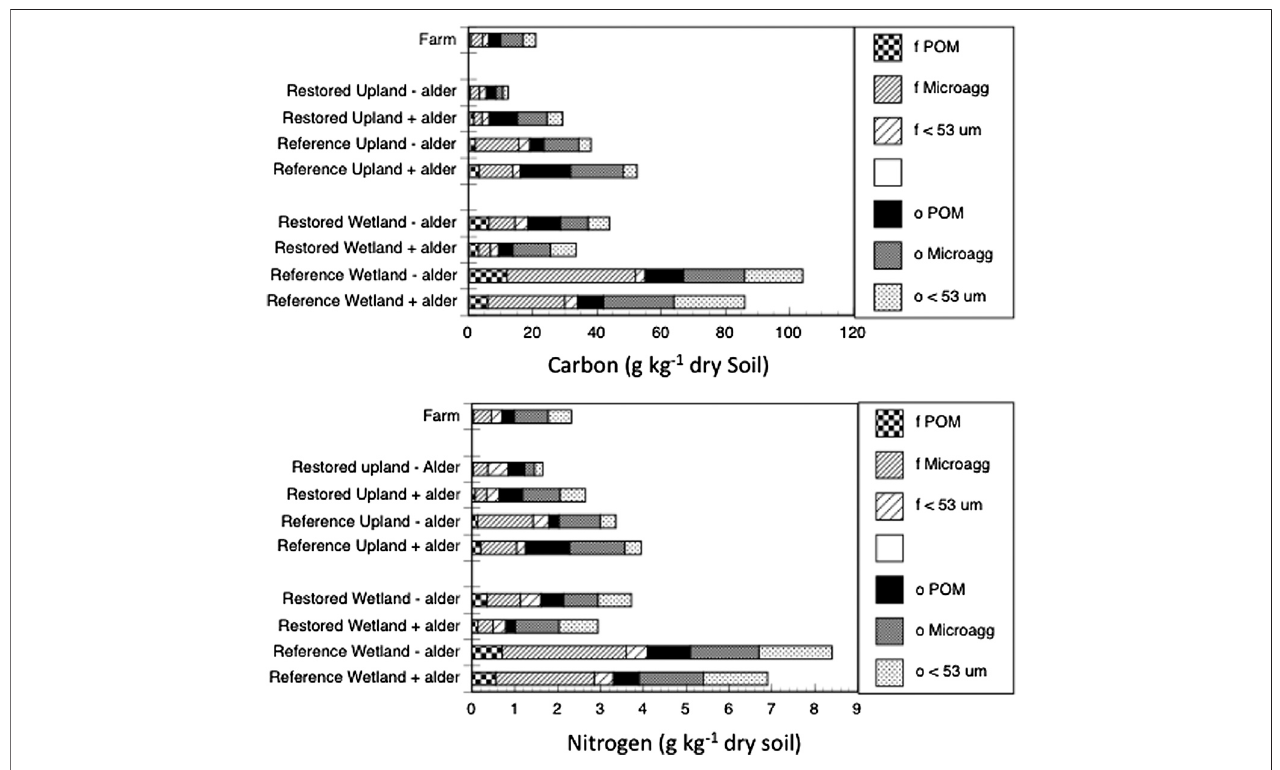
FIGURE 1 | Carbon and nitrogen in aggregate fractions of soil from nine sites. Bars are free fractions in bulk soil (f) and fractions occluded within macroaggregates (o).